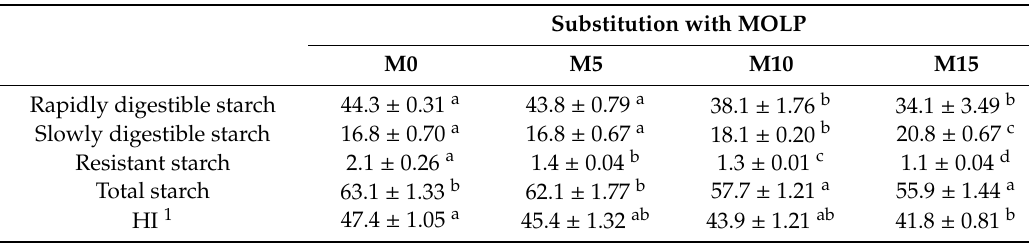
Table 2. Starch fractions (g / 100 g dry matter), total starch (g / 100 g dry matter), and in vitro hydrolysis index (HI) of the cooked-to-optimum pasta samples formulated with di ff erent substitution levels of Moringa oleifera L. leaf powder (MOLP). Results are expressed as mean ± standard deviation ( n = 3). Substitution with